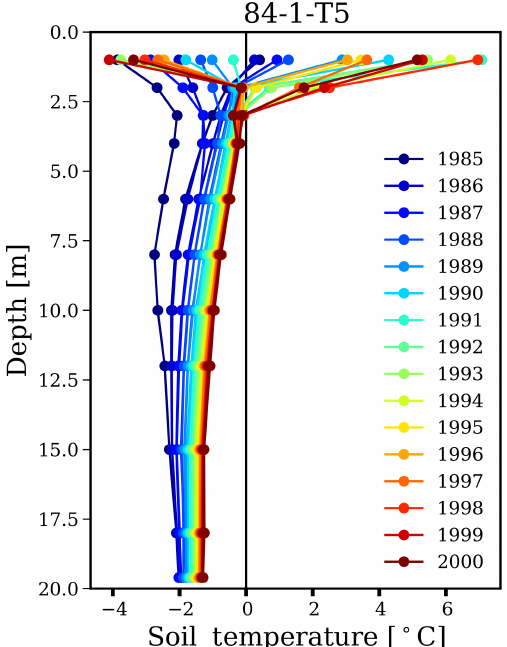
Figure 2. Permafrost Annual maximum and minimum soil temper- ature profiles for the borehole 84-1-T5 located in Normal Wells. Each colour represent an individual year